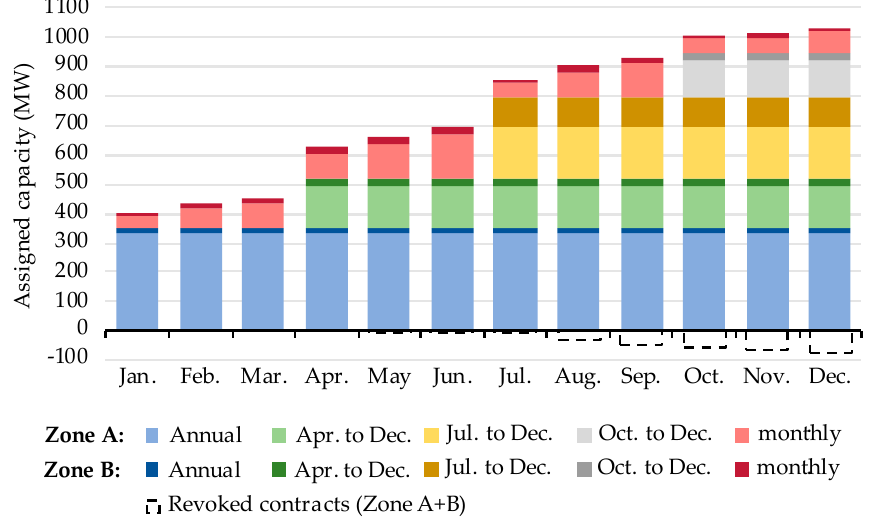
Figure 3. Development of contracted UVAM capacity during the first year of implementation.